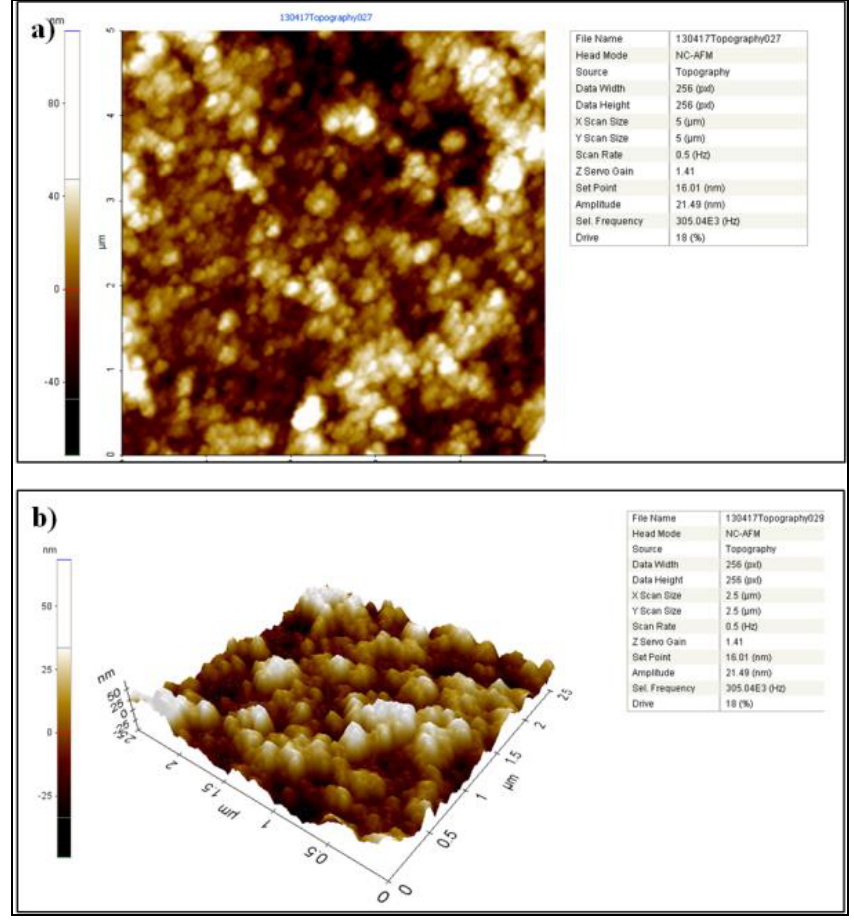
Figure 4. Topographical image ( a ) and 3D image ( b ) of biogenic AgNPs using AFM analysis. In the present report, Copperpod was investigated for the synthesis of AgNPs and was found to be stable for up to 3 months. The utilization of plant and plant-based ele- ments for the manufacture of AgNPs has been exploited by several researchers. However, the mechanism of AgNPs synthesis is not clear; however, most researchers have sug- gested that plant metabolites, such as alkaloids, phenols, tannins, glycosides, enzymes, polysaccharides, proteins and vitamins, may play a major role in the reduction of silver nitrate to AgNPs with good stability [50,51]. Such kinds of phytochemical compounds, including phenolic compounds, flavonoids, xanthoproteins, tannins, saponins, carboxylic acids, coumarins and carbohydrates, which are obtained from the Copperpod plant, are reported to have a high potential in regard to antimicrobial activity [39]. The biogenic synthesis of AgNPs was performed using an aqueous leaf extract of Copperpod, which was then treated with a 1mM solution of silver nitrate to induce the reduction process. The visible colour change to a brown colour is attributed to the excitation phenomenon of SPR bands, which is a characteristic feature of synthesized AgNPs. Carmona et al. [52] and Banerjee et al. [53] observed similar colour changes during the particle-formation process when the leaf extract was treated with silver nitrate. Thus, the reduction process from silver nitrate to AgNPs is coupled with the shift in the pigment of the liquid, especially due to the phenomenon of surface plasmon absorption of AgNPs. Moteriya and Chanda also suggested that the colour change from a colourless solution to a brown colour during the formation of AgNPs using the extract of C. pulcherrima was mainly due to a surface plasmon resonance phenomenon